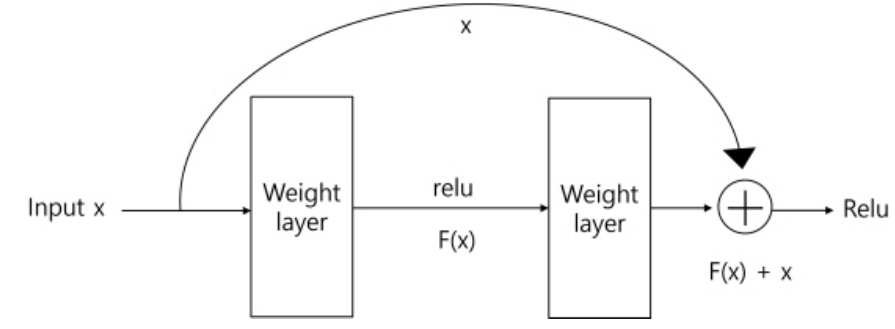
Figure 3. Residual block structure in ResNet.